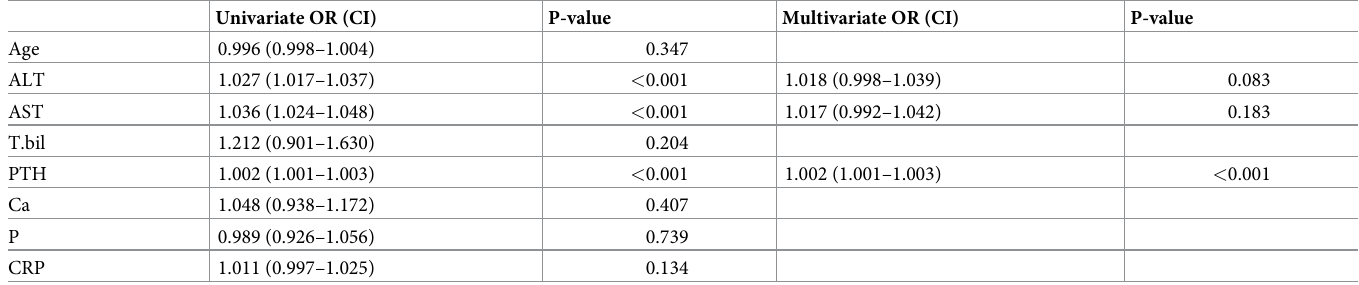
Table 6. Logistic regression analysis for predictors of higher ALP ( � 71 IU/L). Univariate OR